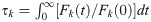
Relaxation times of chain conformations.(A) Time evolution of the root mean square distance between a pair of loci ri,j(t) at time t relative to its initial value (ri,j(0)) averaged over all pairs, defined by δ(t) = [2∑i>j(ri,j(t) − ri,j(0))2/N(N − 1)]1/2. (B) Normalized intermediate scattering function Fk(t)/Fk(0), with different values of wave number k, were calculated from BD simulation trajectories of the chromosome. (C) The chain relaxation time (τ) for different wave number k was estimated by evaluating τk=∫0∞[Fk(t)/Fk(0)]dt.